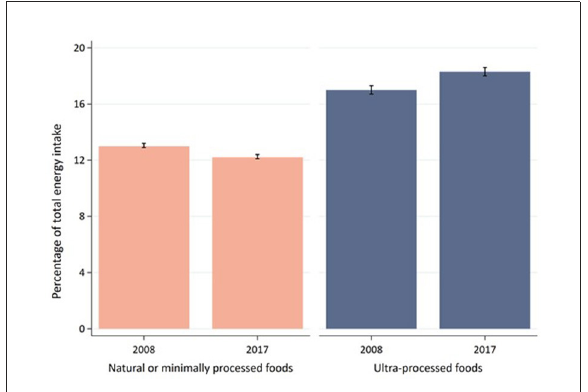
FIGURE1 Percentage of total energy intake (mean and 95% confidence intervals) from the set of healthy foods and ultra-processed foods at the national level in 2008 and 2017 by Brazilian adults aged 20 years or more. Estimates for Healthy foods: 13.0, 95%CI 12.9; 13.2 (2008) and 12.2, 95%CI 12.1; 12.4 (2017); Estimates for Ultra-processed foods: 17.0, 95%CI 16.7; 17.3 (2008) and 18.3, 95%CI 18.0; 18.6 (2017). Evidence of differences in the estimates between the 2008 and the 2017 surveys was considered based upon the non-overlapping of confidence